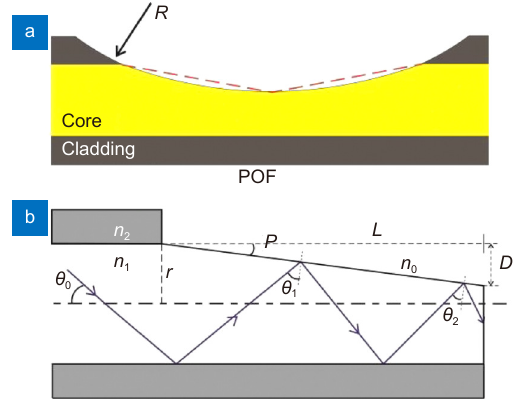
Fig. 1 | Schematic diagram of SP-area. ( a ) Structural equivalence. ( b ) Optical